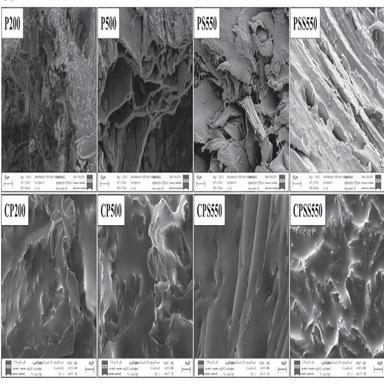
FE-SEM images of (a) PMS biochar (b) P and PS biochar.